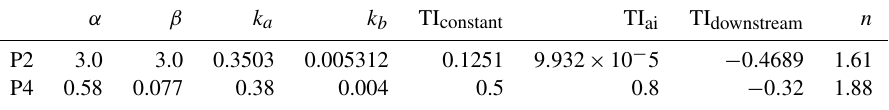
Table 3. Model parameters for FLORIS used by P2 and P4. P2 used a set of in-house calibrated parameters; P4 used the default values. Parameters description (NREL, 2021): α and β are parameters determining the dependence of the downstream boundary between the near- wake and the far-wake region on the turbulence intensity and the turbine’s induction factor, respectively; k a and k b are parameters used to determine the linear relationship between the turbulence intensity and the width of the Gaussian wake shape; TI constant is a constant scaling the wake-added turbulence intensity; TI ai is the axial induction factor exponent used in the calculation of wake-added turbulence; TI downstream is the exponent applied to the distance downstream of an upstream turbine normalised by the rotor diameter, used in the calculation of wake-added turbulence; and n is the power–yaw loss exponent. α